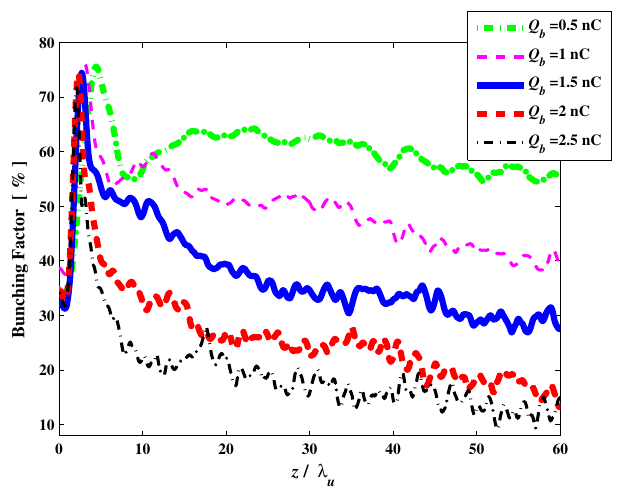
FIG. 4. Bunching factor at the central radiation frequency of 1.5 THz as a function of number of undulator periods for various bunch